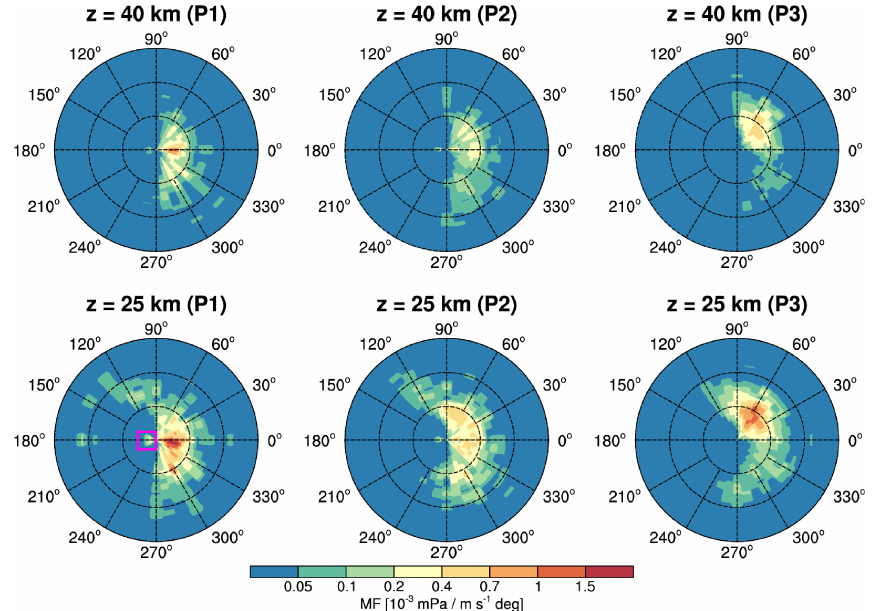
Fig. 4. As Fig. 3 but for model temperatures. Polarization relations are employed to calculate the momentum flux from the temperature amplitudes.